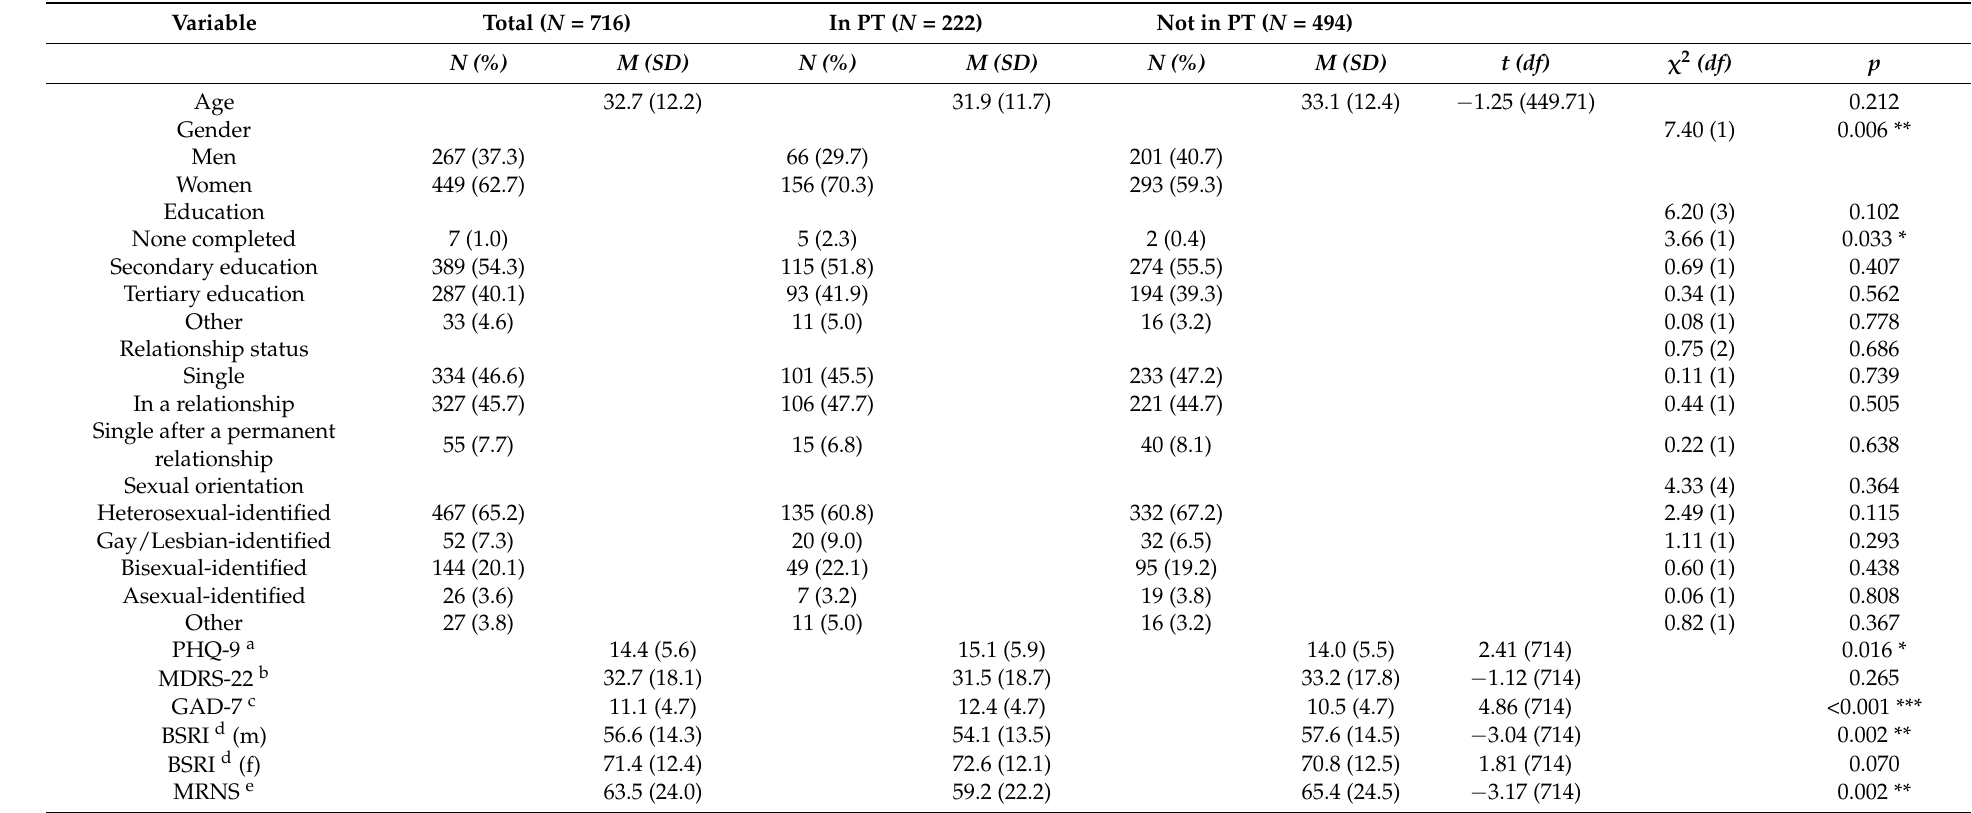
Table 1. Descriptive statistics for the